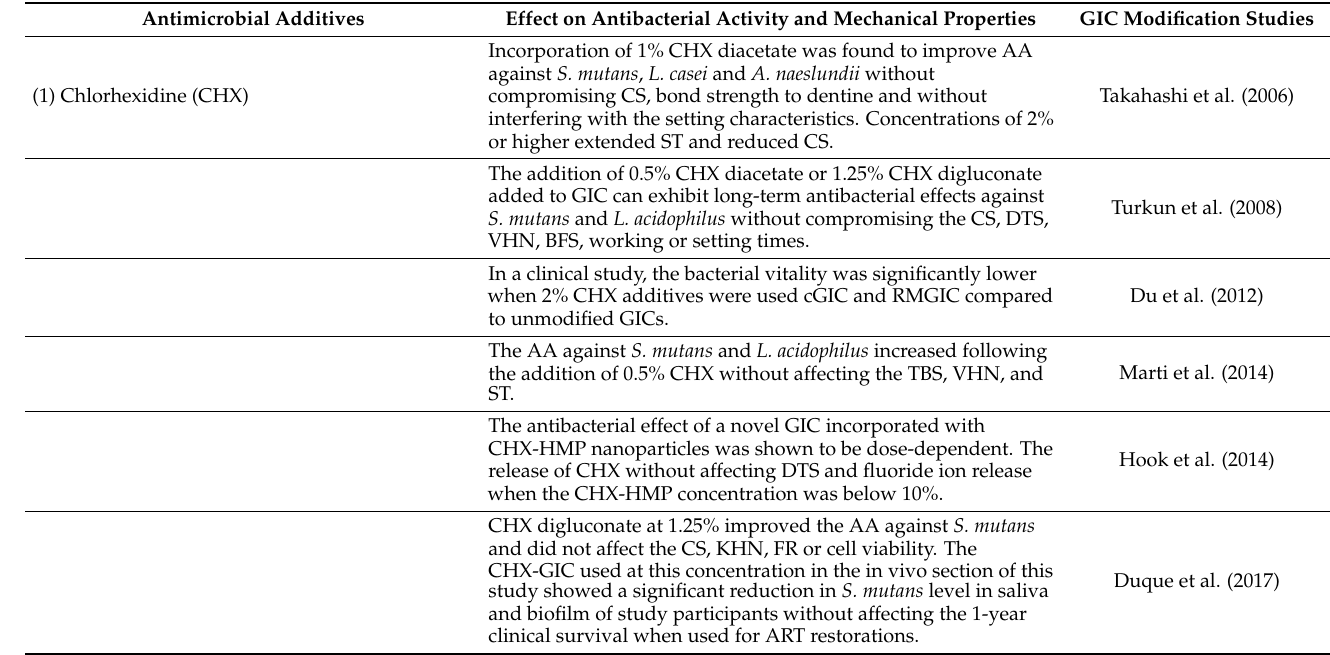
Table 2. Modification of GIC using various additives for enhancing antibacterial activity [2,4,30,77, 87,91–94,96–99,101,103,105–109,114,119,120,123,127,129,133–146]. Antimicrobial